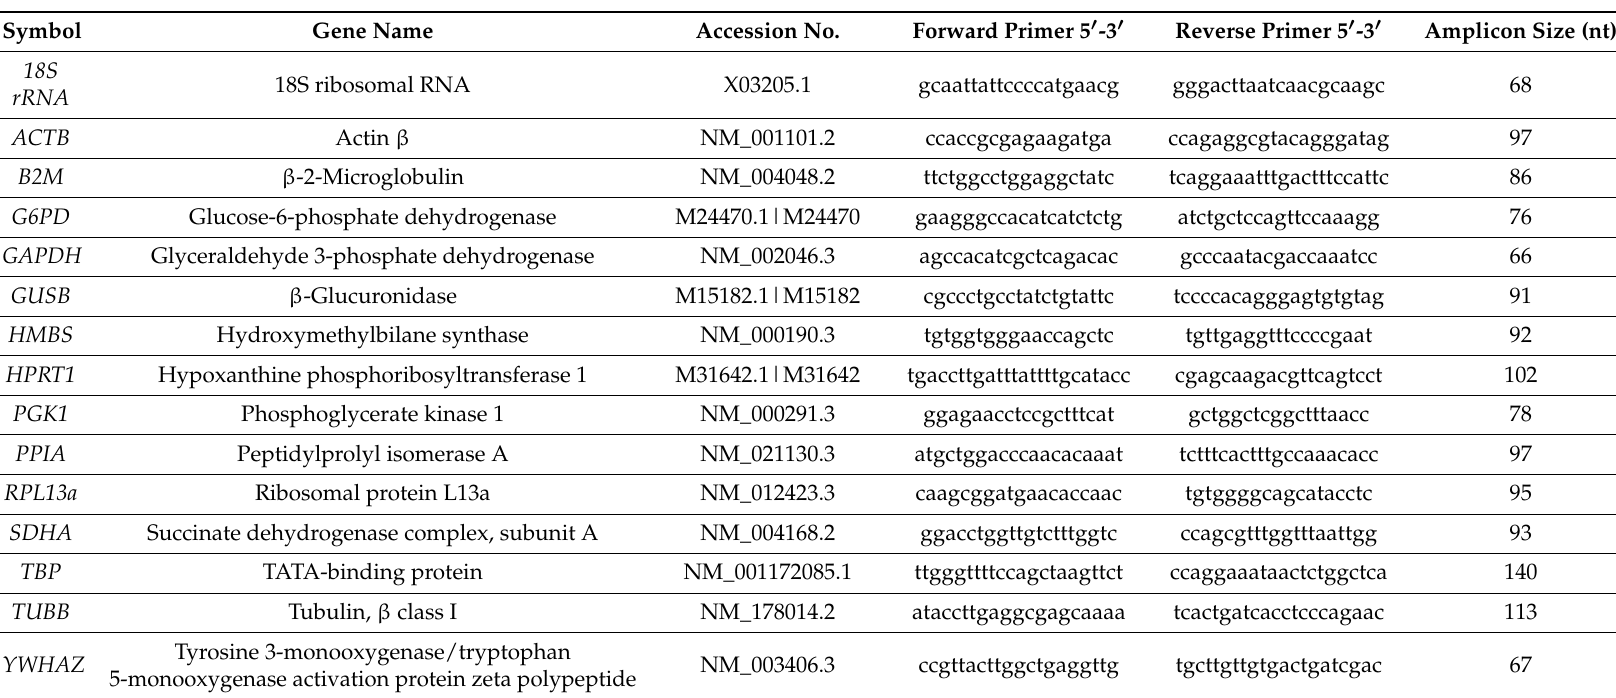
Table 1. Candidate housekeeping genes (HKG). Gene symbol, name, accession number, primer forward and reverse sequences, and amplicon size are